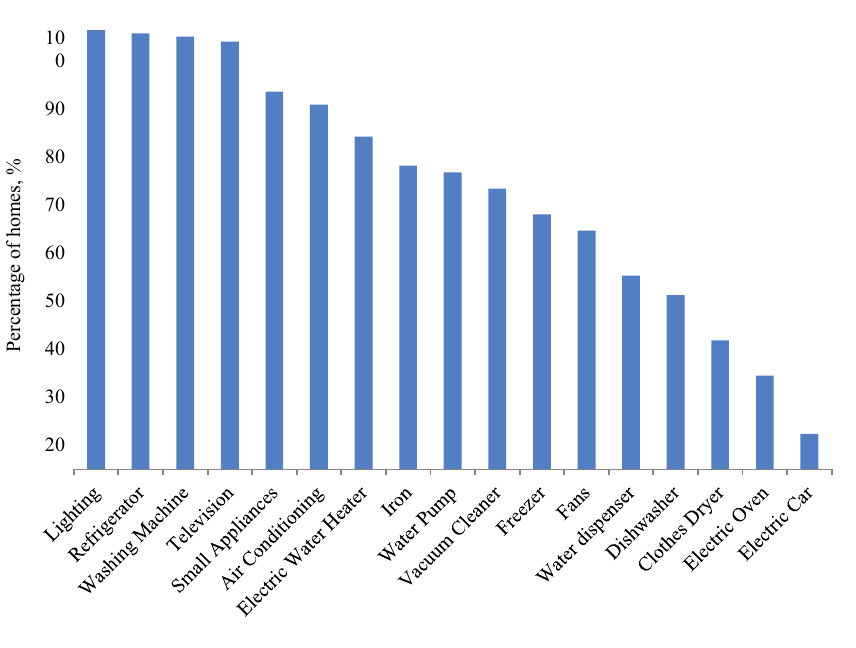
Fig. 1. Percentage of homes containing different appliances and electrically powered equipment.